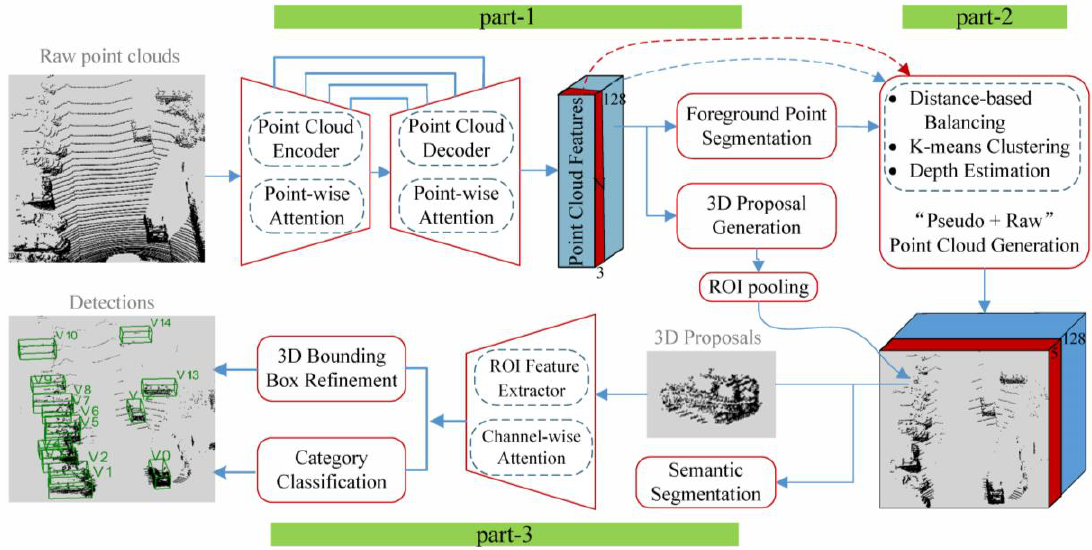
Figure 1. The architecture of the proposed KDA3D: part-1 for 3D foreground segmentation and proposal generation; part-2 (optional) for point cloud density enhancement; part-3 for semantic segmentation, 3D box refinement, and category classification.